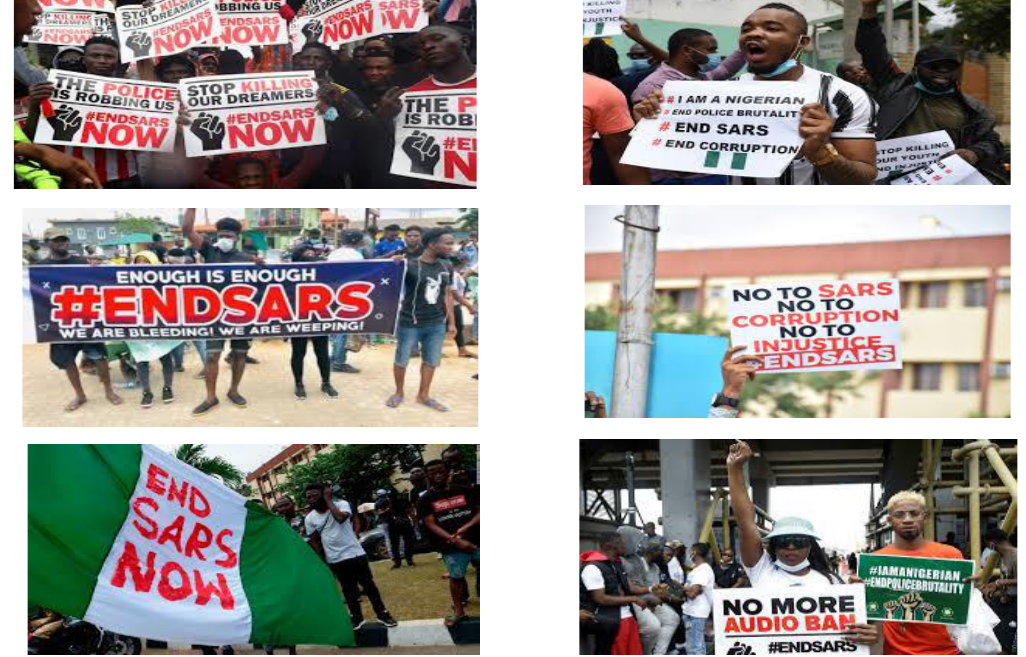
Figure 3: #EndSARS protesters with different placards; Source: West, 2020; Lawal, 2020; Nsemgh, 2020; Bolashodun, 2020. The protests venues, as mentioned earlier, were communicated on social media platforms and people attended these protests in their thousands both throughout and outside the country. Some of the converging points of the protests in Nigeria were the Nigerian National Assembly complex in Abuja, the Lekki tollgate in Lagos, and other strategic locations in the country. The protesters at some of the protest sites were seen to sleep there for days, waiting for the government to respond to their demands. Protesters conducted Friday and Sunday services for Muslim and Christian worshippers respectively at these venues. The figures below indicate protesters sleeping and camping at the Lagos State House of Assembly and at the Lekki tollgate: